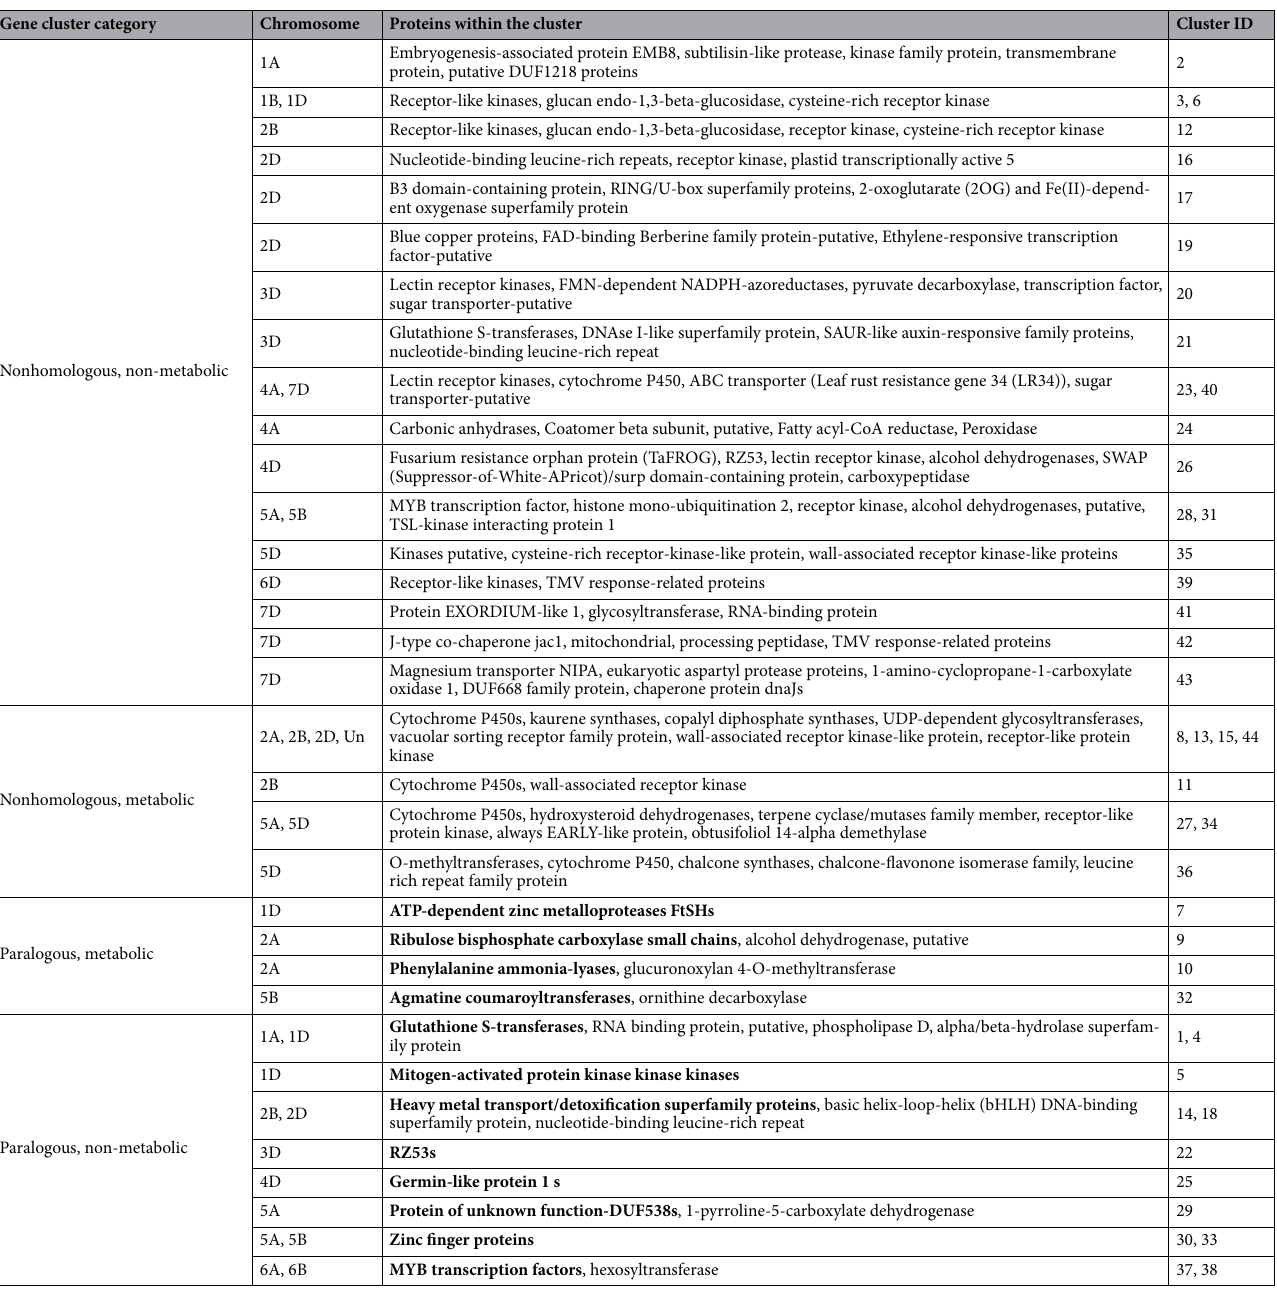
Table 1. Fusarium -responsive gene cluster categories and contents. Encoded proteins by Fusarium -responsive gene within each cluster are listed. Paralogous proteins that represented ≥ 60% of the total protein content of the cluster are highlighted in